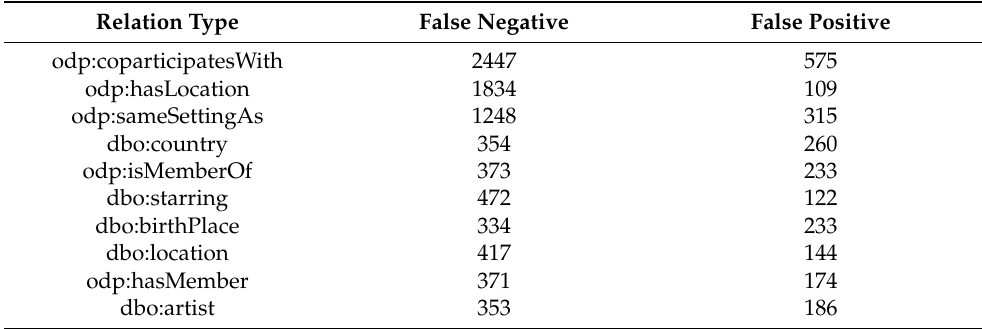
Table 3. False negative/positive relation predictions for